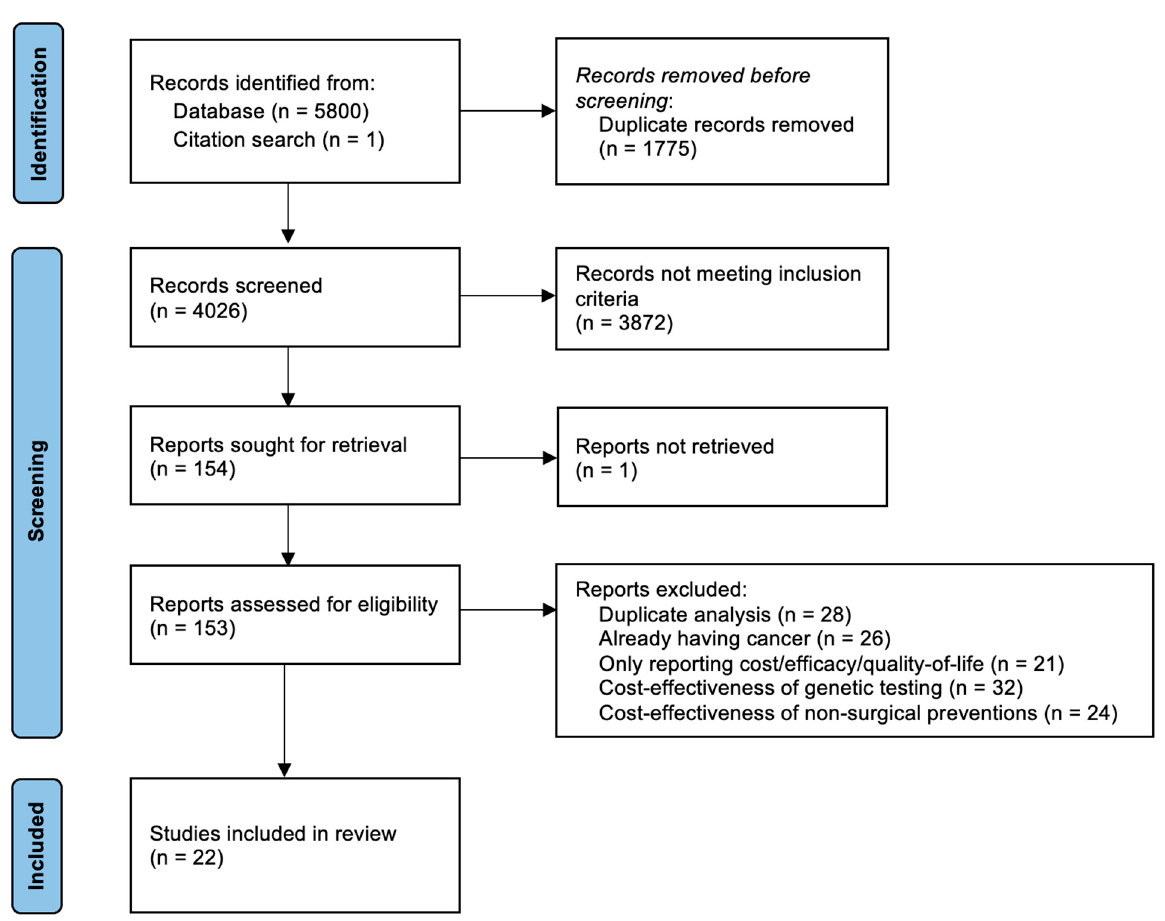
Figure 2. PRISMA flow diagram.